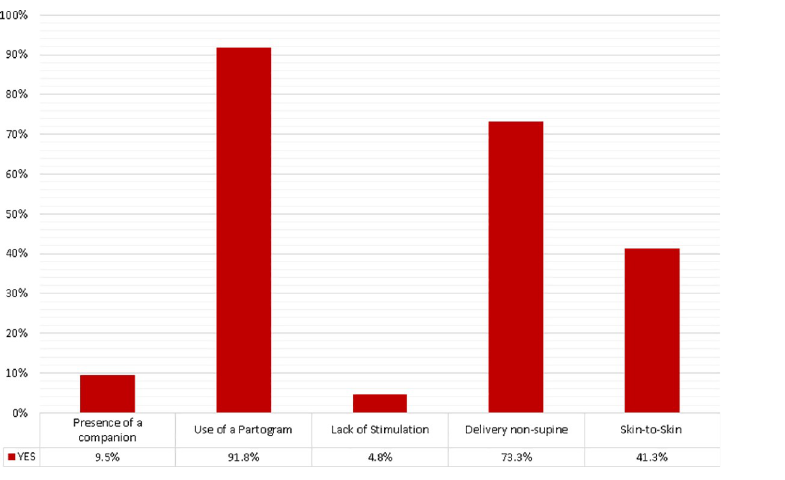
Fig 3. Findings of the Bologna score